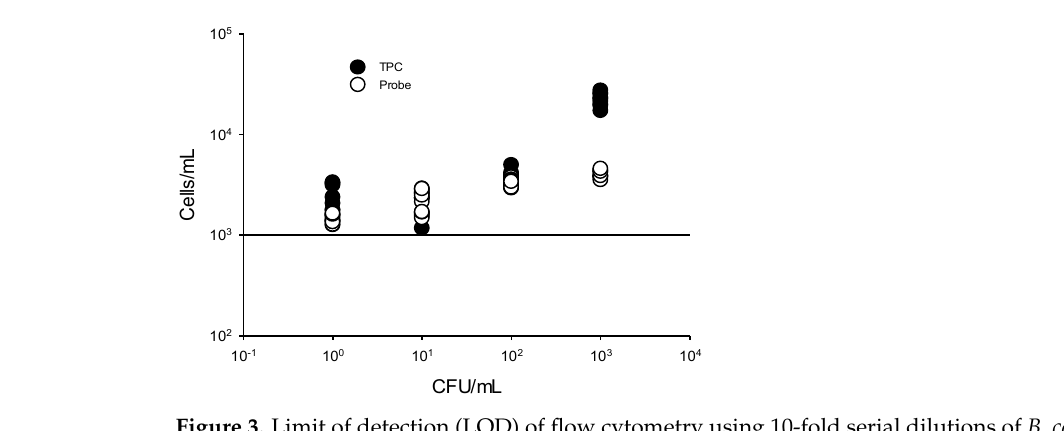
Figure 3. Limit of detection (LOD) of flow cytometry using 10-fold serial dilutions of B. cenocepacia AU1054 ranging from 1 to 10 3 CFU/mL.